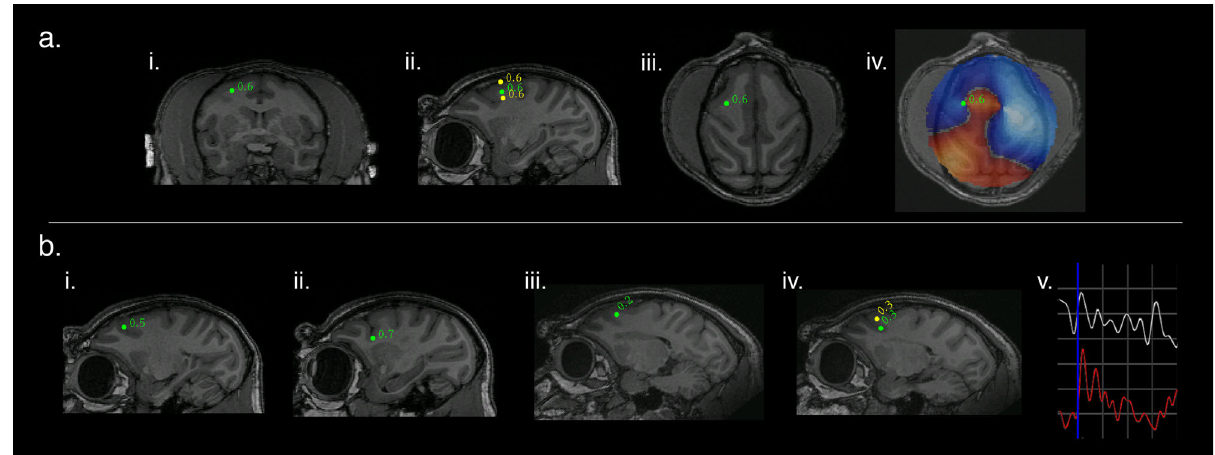
Fig. 2 SAM source localization of optogenetically evoked MEG responses in the right arcuate sulcus in two representative animals and stimulation types. a An example of optogenetic stimulation localized by dual-state SAM to the posterior bank of right arcuate sulcus for NHP M1 in the coronal ( i ), sagittal ( ii ), and axial planes ( iii ), for a stimulus of 50 ms square light pulses. The whole brain, un-thresholded, dual-state SAM SPM (voxel size of 750 µ m 3 , iv ) reveals synchronized activity (red voxels) arising from the stimulation site and surrounded by desynchronization (blue voxels). Green dot and number indicate a peak in the SPM plus the associated pseudo-t value. b Right SAM arcuate peaks for four additional and different optical stimuli in two different NHPs. ( bi – ii ) present arcuate activations for M1 and ( iii - iv ) shows arcuate stimulation for M2. ( bi – ii ) is the same subject (M1) as presented in ( ai – iv ); ( i ) depicts the arcuate peak for 8 Hz sine waves, and ( ii ) shows the arcuate peak for 40 Hz sine waves. Arcuate stimulations in M2 are presented in ( iii – iv ); ( iii ) shows the arcuate peak for 10 ms square pulses and ( iv ) shows the arcuate peak for 20 Hz square wave pulse trains. A single trial ( v ) of an LFP recorded by the optrode and a simultaneous SAM virtual electrode for an arcuate peak (as seen in biii ). Blue vertical line indicates stimulus onset (10 ms pulses). Both the LFP (white) and virtual electrode (red) exhibit a rapid peak following stimulation and have similar features and time courses. One